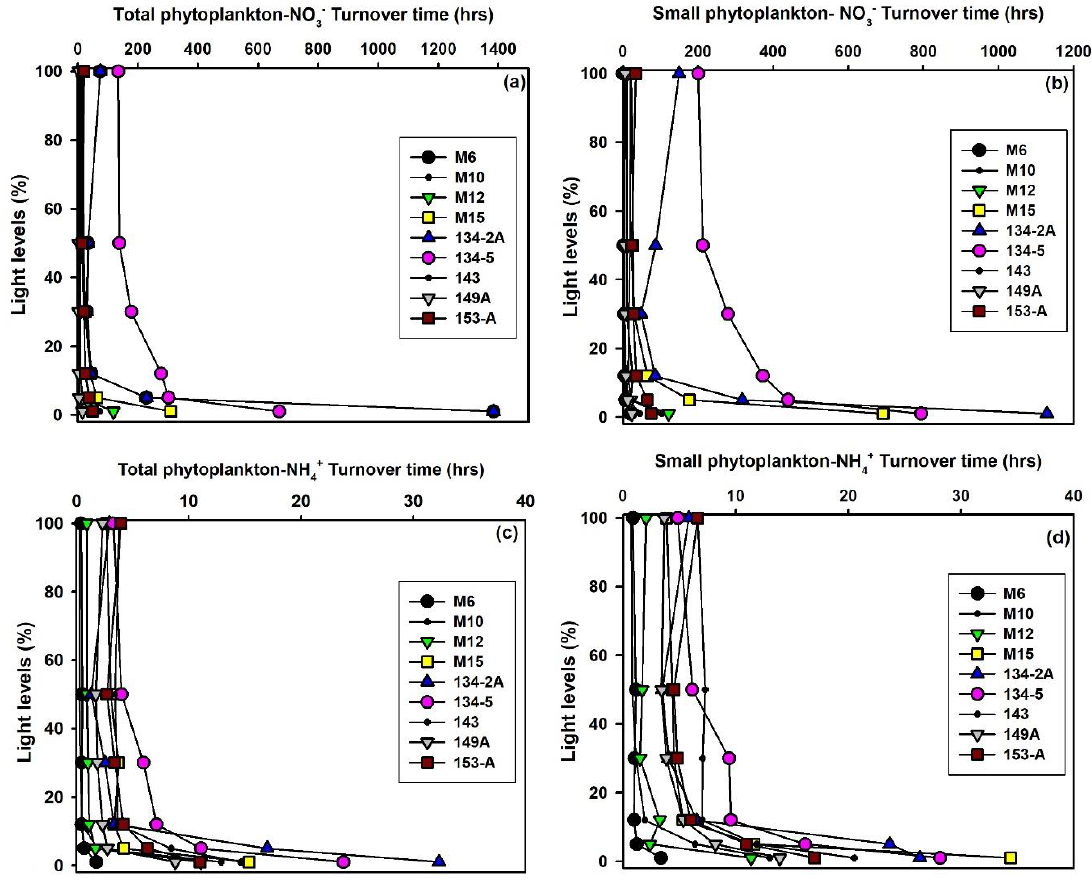
Figure 8. Depth profiles of turnover times of NO 3 − and NH 4 + substrates by total and small phytoplankton in the East / Japan Sea during 2015. ( a , b ) denote the NO 3 − turnover times by total and small phytoplankton, respectively, and ( c , d ) denote the NH 4 + turnover times by total and small phytoplankton, respectively.